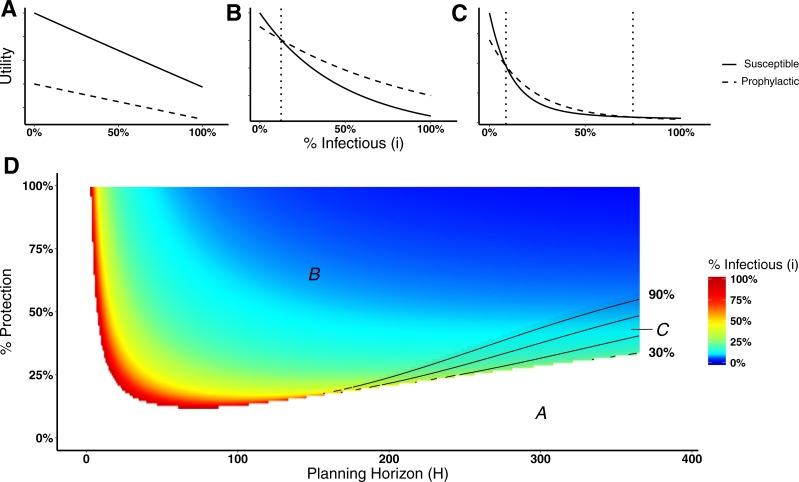
Heat map of switching points for Disease 1.(A) Situation in which non-prophylactic behavior is always more advantageous than prophylactic behavior regardless of the proportion of infectious agents. (B) Situation in which above a certain proportion of infectious agents (indicated by the vertical dotted line), the prophylactic behavior is more advantageous than non-prophylactic behavior. (C) Situation in which prophylactic behavior is more advantageous whenever the proportion of infectious agents is within a range of values represented by the two vertical dotted lines and less advantageous otherwise. (D) Proportion of infectious agents above which prophylactic behavior is more advantageous than non-prophylactic behavior given the percentage of protection (% Protection) obtained for adopting prophylactic behavior (1 − ρ) × 100 (y-axis) and the planning horizon H (x-axis). The three regions in (D) represent the situations shown in (A), (B), and (C). In region A, agents never adopt prophylactic behavior. In region B, agents adopt prophylactic behavior above the reported proportion of infectious agents. In region C, agents adopt prophylactic behavior only if the proportion of infected agents is between the proportion of infectious agents represented by the color gradient and the proportion represented by the contour lines.